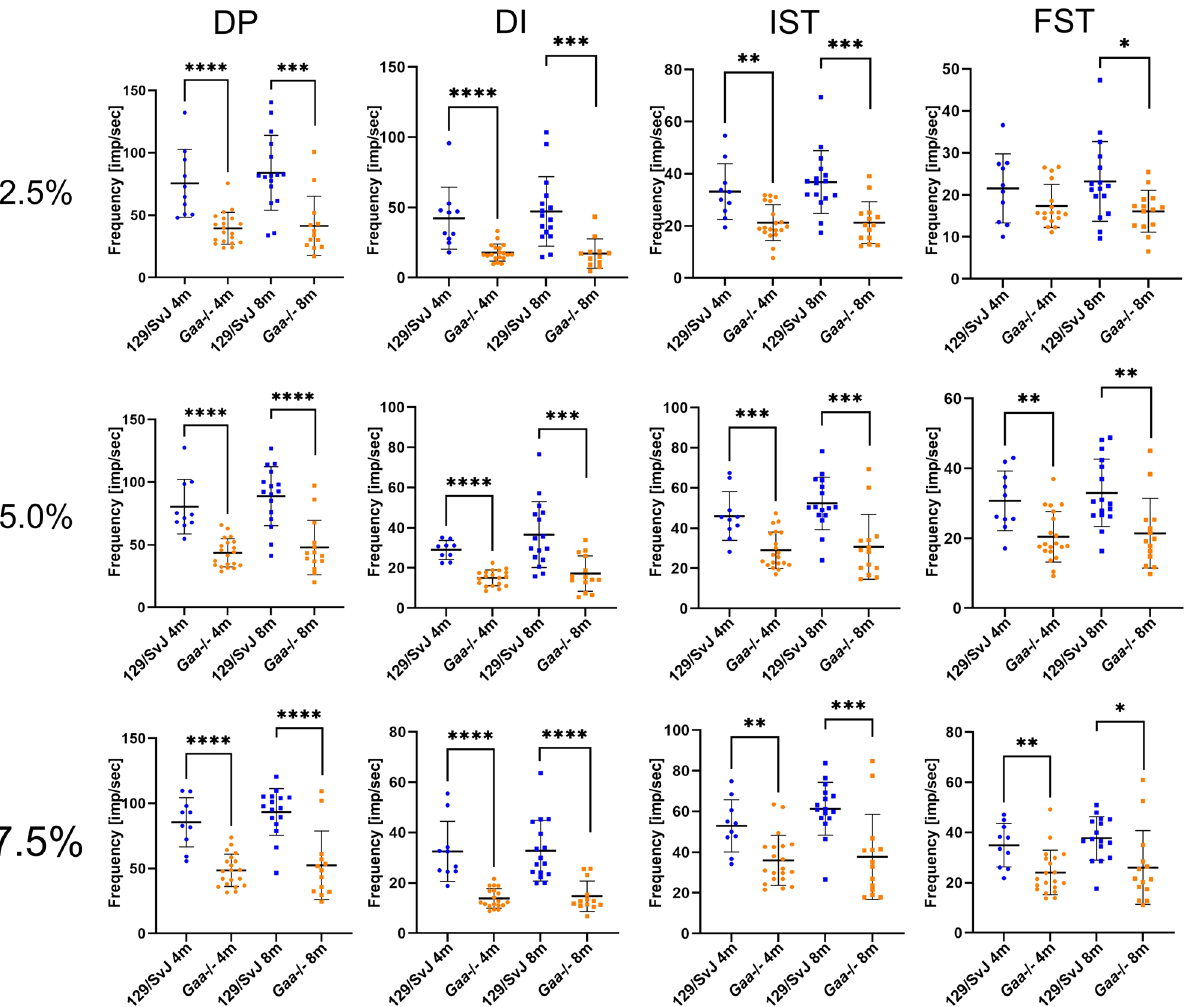
Figure 3. Stretch-responsive muscle spindles from Gaa −/− mice have lower instantaneous frequencies compared to control mice at all time points during ramp-and-hold stretches. The frequency at four time points during a ramp-and-hold stretch (dynamic peak (DP), dynamic index (DI), initial static time (IST) and final static time (FST); for details of these time points see “Methods” section) were lower in Gaa −/− mice (orange dots) compared to age-matched wildtype 129/SvJ control mice (blue dots). This was independent of the length change (2.5, 5.0 and 7.5% of L 0 ) and of the age of the mice (4- and 8-month-old mice, respectively). Each dot represents the recording of a single muscle spindle. Bars show the mean ± SD with N = 4 (4-month-old 129SvJ), N = 8 (4-month-old Gaa −/− ), N = 6 (8-month-old 129SvJ) and N = 16 (8-month-old Gaa −/− ). Statistical significance was calculated using the unpaired student